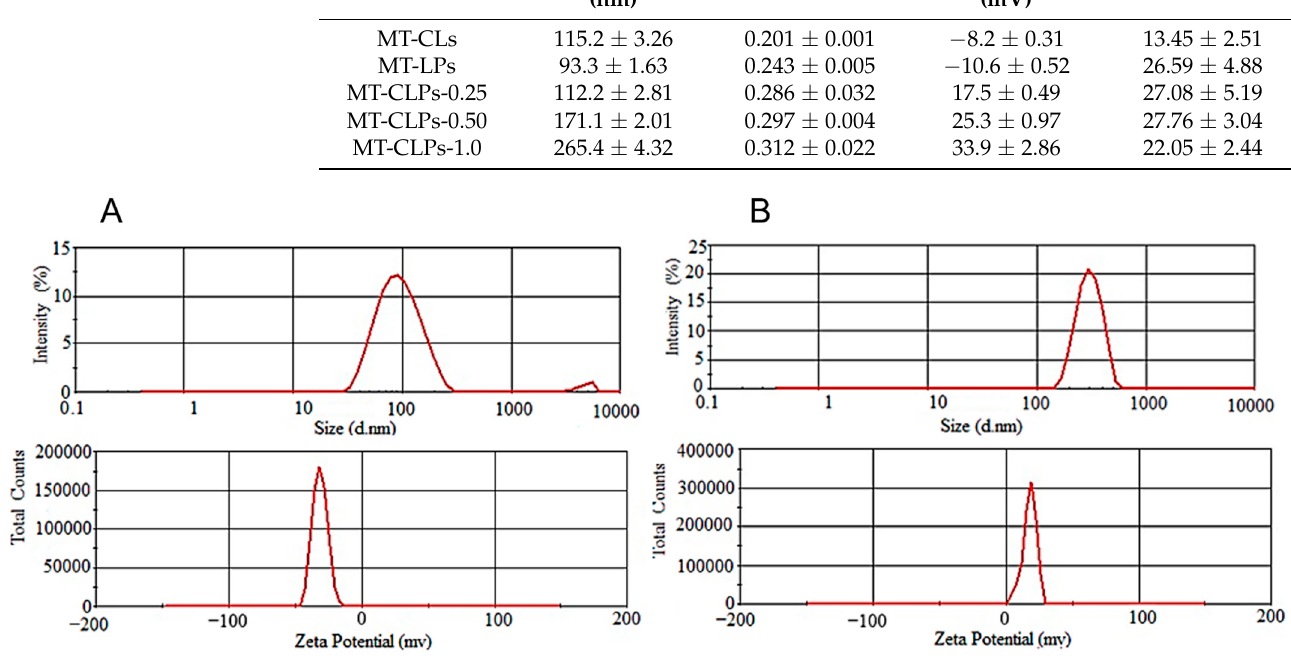
Table 1. The characterization of the different types of liposomes ( n = 3, mean ± SD). Formulations